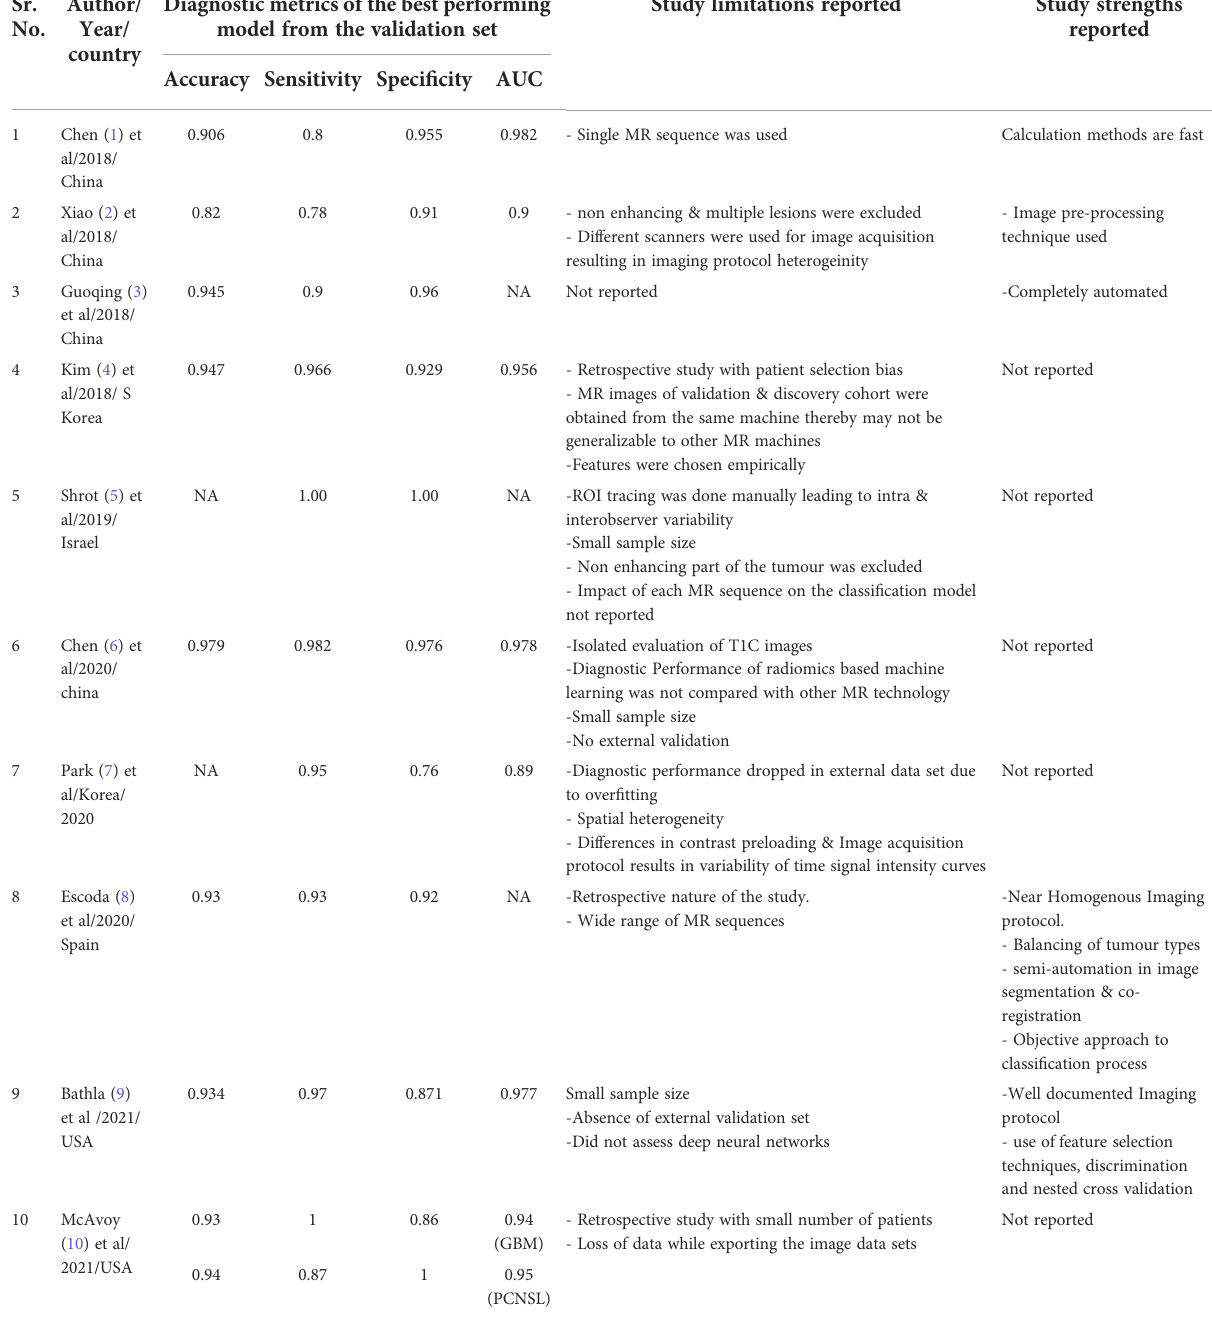
TABLE 2 Summary of the results of the reviewed studies. Diagnostic metrics of the best performing model from the validation